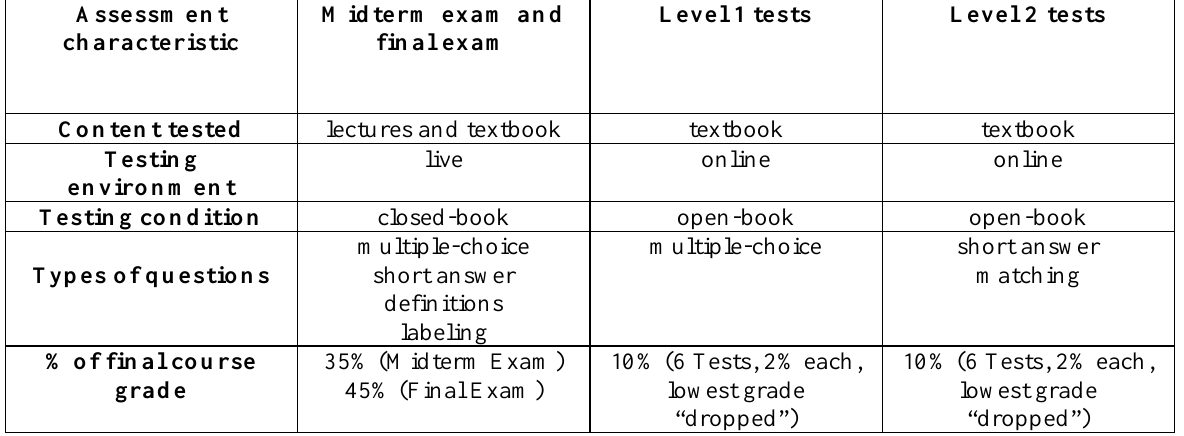
Comparison Between Major Assessments in the